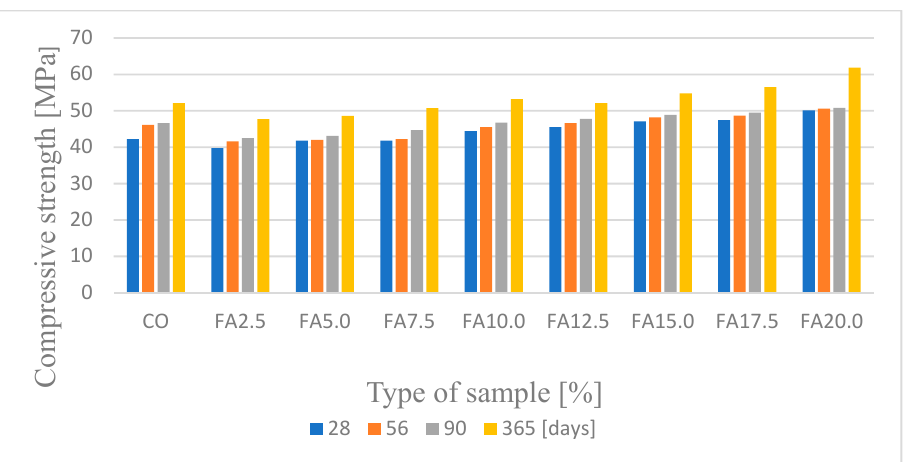
Figure 12. Average compressive strength in different periods of concrete maturation.